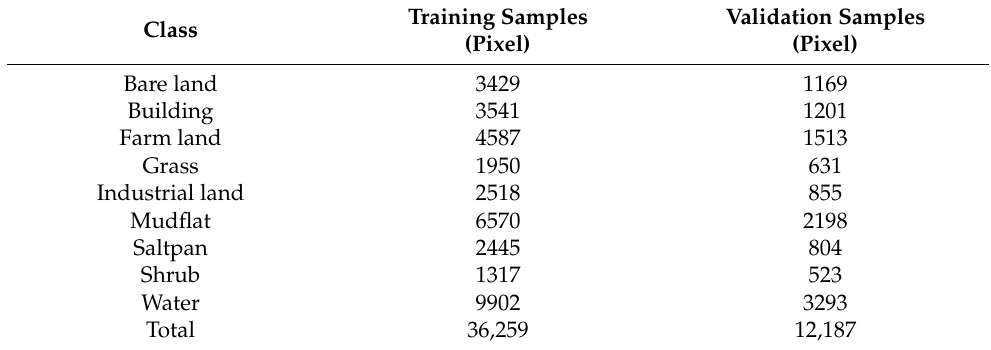
Table 2. The number of classification training and validation samples per